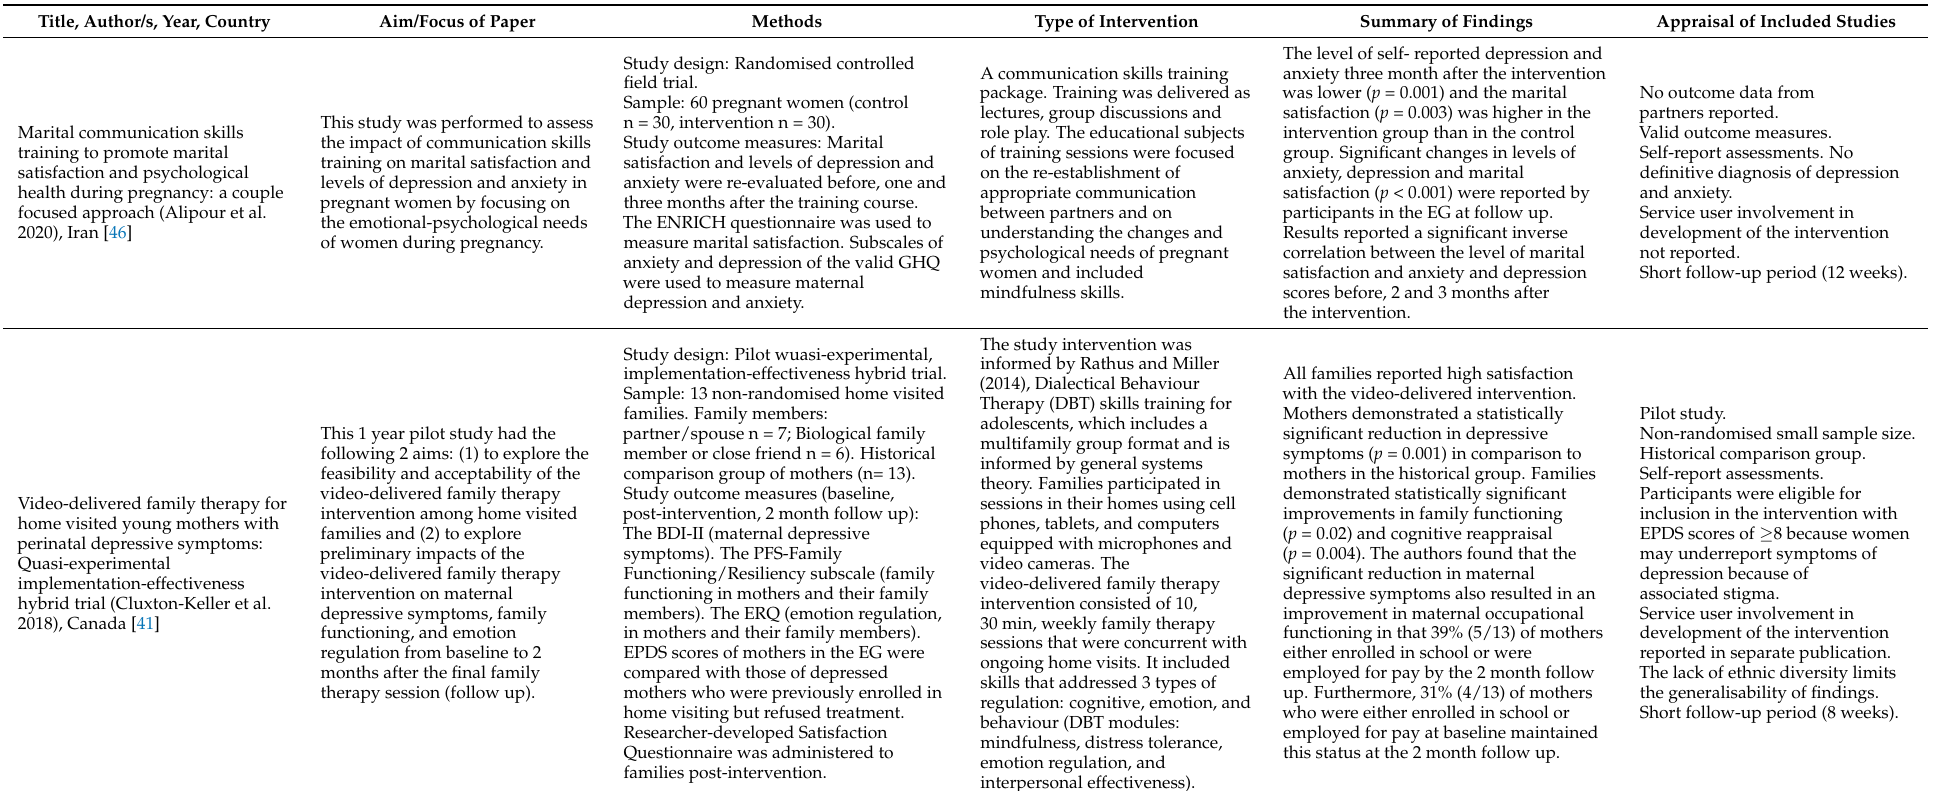
Table 3. Data extraction